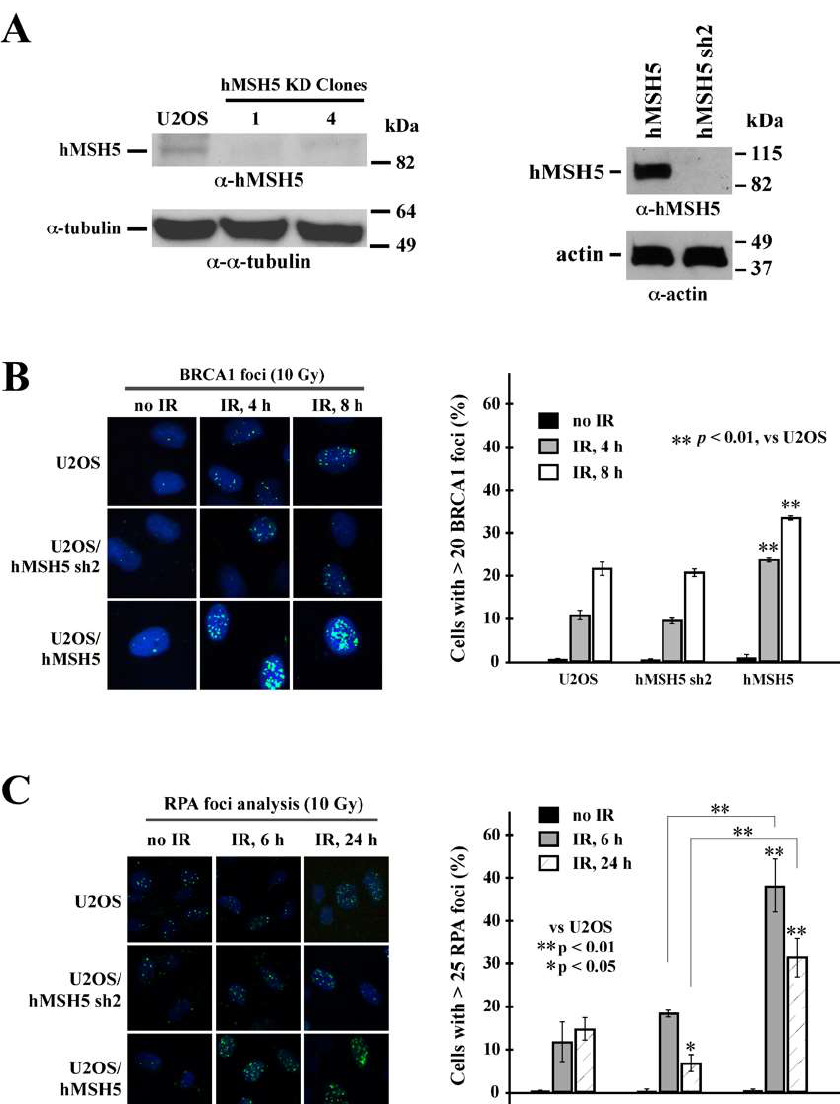
Figure 4. Analysis of the effect of hMSH5 on IR-induced BRCA1 and RPA foci formation. ( A ) Im- munoblotting analysis of RNAi-mediated hMSH5 silencing (by hMSH5 sh2) in two representative stable clones, of which clone#1 was used for all subsequent studies. Immunoblotting of U2OS/hMSH5 stable transfectant is shown on the right. ( B ) BRCA1 foci formation at 4 or 8 h after 10 Gy IR treatment in U2OS, U2OS/hMSH5 sh2, and U2OS/hMSH5 cells. A panel of representative images of BRCA1 foci is provided on the left. Three separate foci counts, each with 100 cells, were analyzed for every treatment condition and time point. The mean percentages of cells possessing 20 or more BRCA1 foci/nucleus were graphically displayed (on the right) together with their corresponding standard deviations (error bars). ( C ) RPA foci formation at 6 and 24 h post 10 Gy IR in U2OS, U2OS/hMSH5 sh2, and U2OS/hMSH5 cells. Representative images of RPA foci for all cell lines are shown on the left. Bar graphs are employed to show the percentage of RPA foci formation (>25 foci). Asterisks are used to indicate statistically significant differences between categories. Error bars are standard deviations of the means that were determined from three 100-cell replicates. Statistical significance was assessed by Student’s two-tailed t